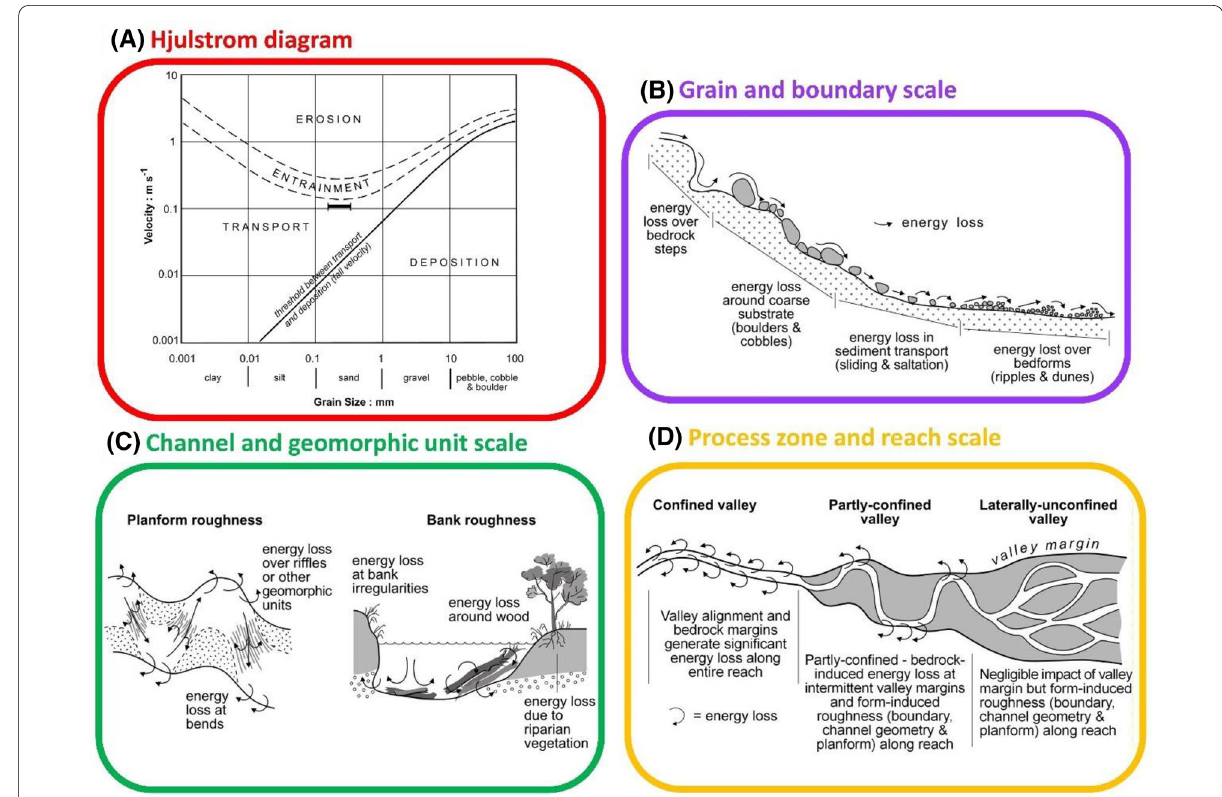
Fig. 3 Working with process: Impelling and resisting forces in river systems. A Hjulstrom diagram describes the relationship between bed material size and sediment entrainment, transport and deposition in rivers, showing that sands are the most readily mobilised materials in river systems (rivers love sand). B At the grain scale, interactions between the size and organisation of bed materials (boundary resistance) and flow (conditioned largely by slope and depth) influence the frequency of bed mobilisation and the distance materials are transported. C Channel geometry and planform influence the extent of the bed/bank surface against which flow interacts (and the form resistance thereof). D Valley scale resistance reflects the extent to which the channel abuts valley margins (or other lateral constraints such as terraces and anthropogenic structures) relative to planform-induced